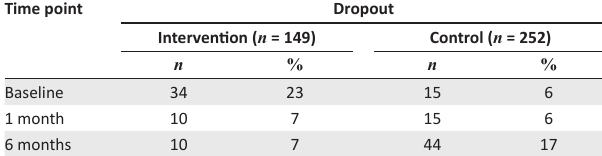
TABLE 1: Dropout rate at baseline, 1 and 6